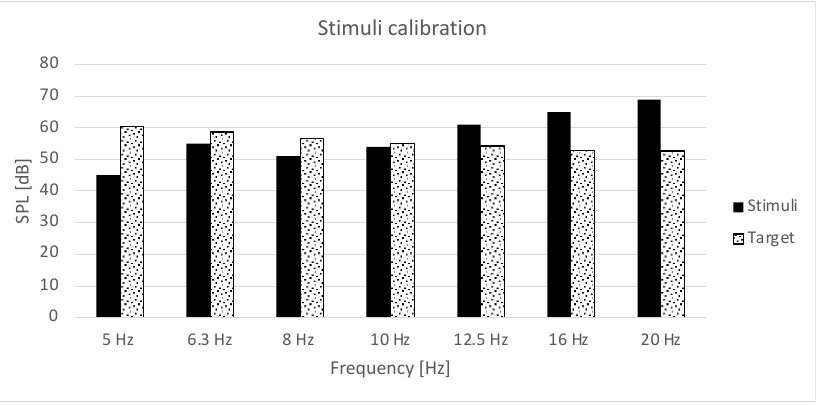
Figure 2. The target level of the wind turbine noise and the resulting stimuli after calibration.